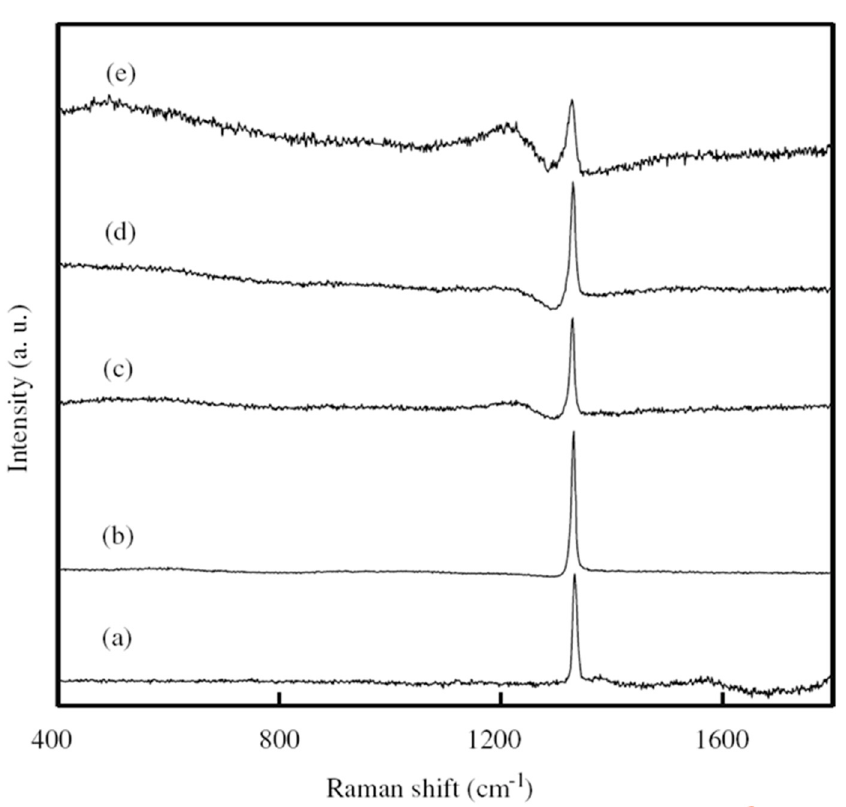
Figure 4. Raman pattern of BDD grown with the boron of ( a ) 0 sccm, ( b ) 2 sccm, ( c ) 5 sccm, ( d ) 10 sccm and ( e ) 20 sccm